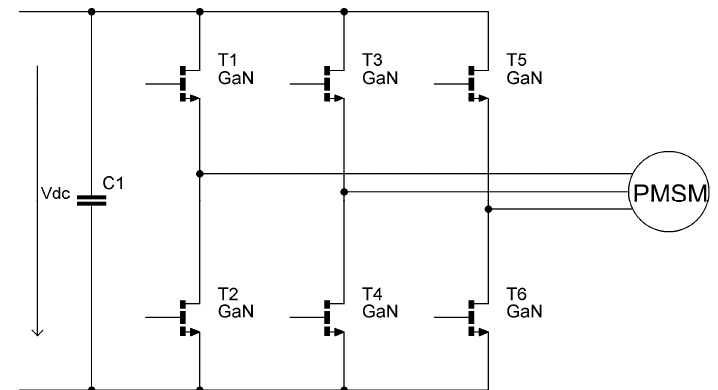
Figure 1. Three-phase two-level GaN voltage-source inverter.